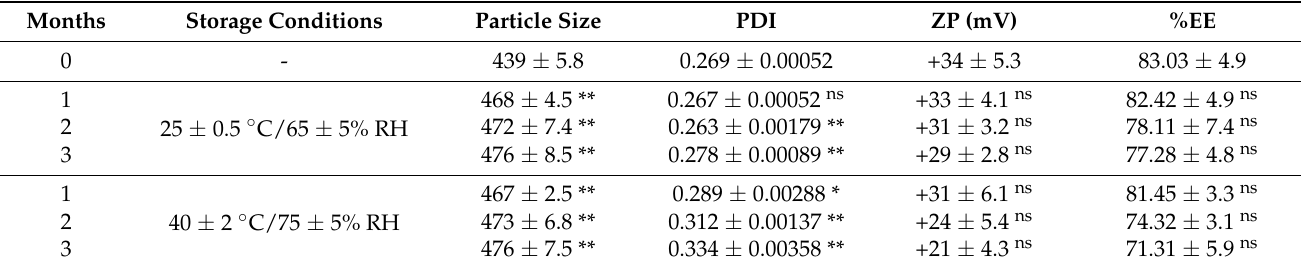
Table 3. Stability data of optimized LPHNPs